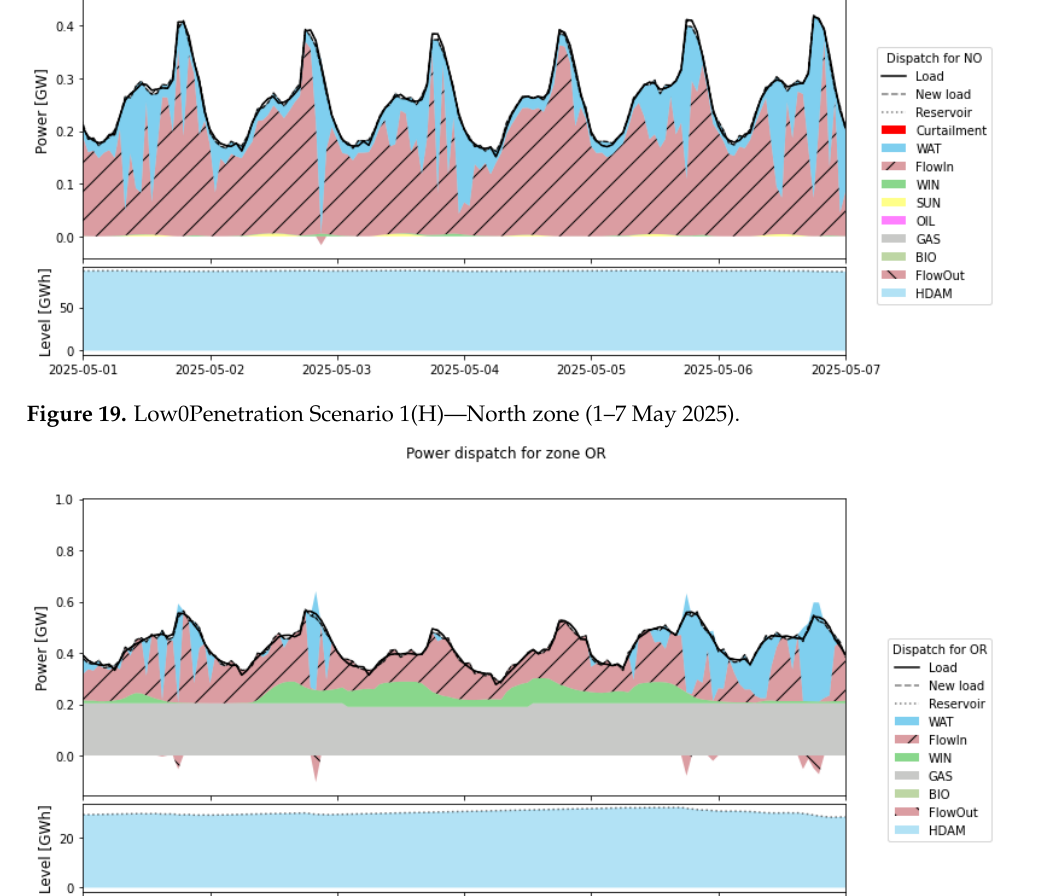
Figure 20. Low-Penetration Scenario 1(H)—Oriental zone (1–7 May